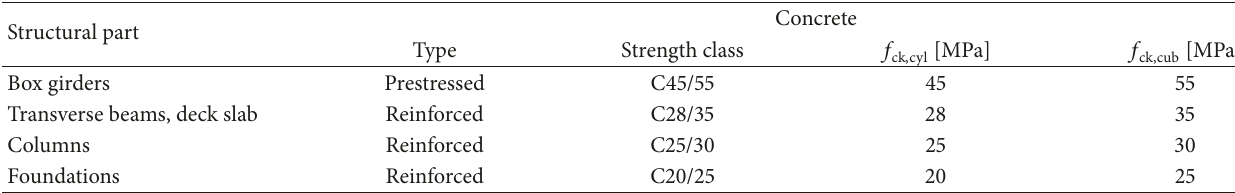
Table 1: Class of concrete used for each structural part.